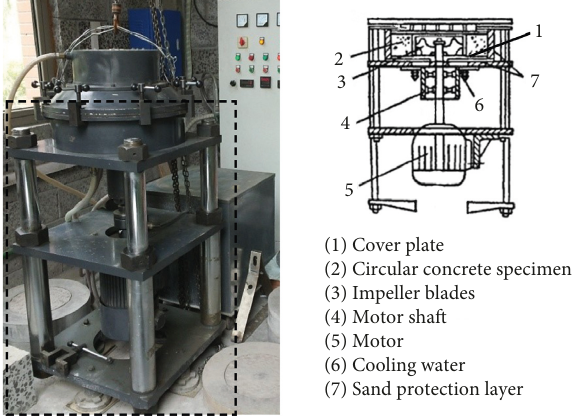
Figure 12: Abrasion-resistance apparatus.